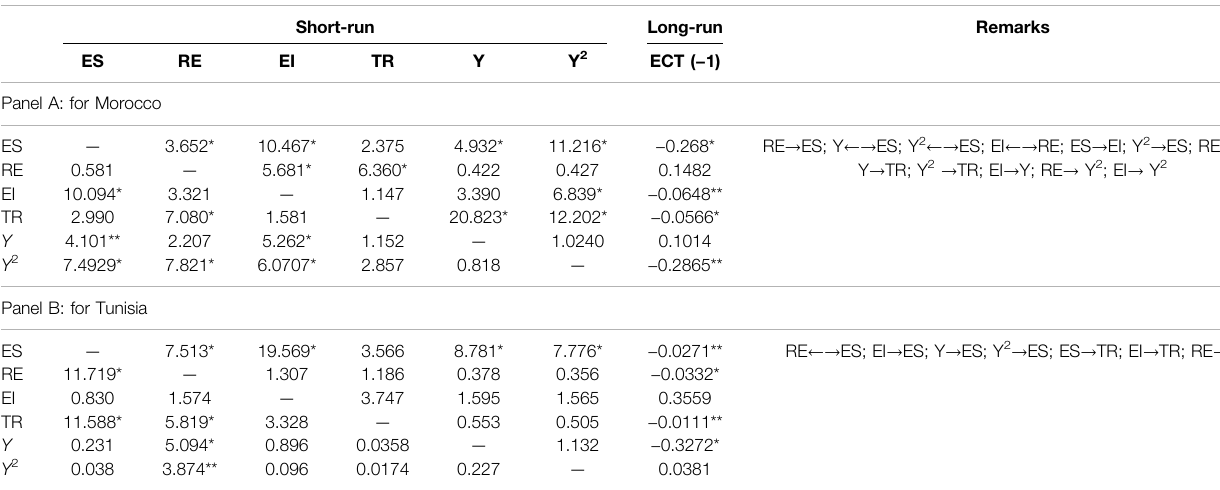
TABLE 10 | Results of causality test under VECM. Short-run